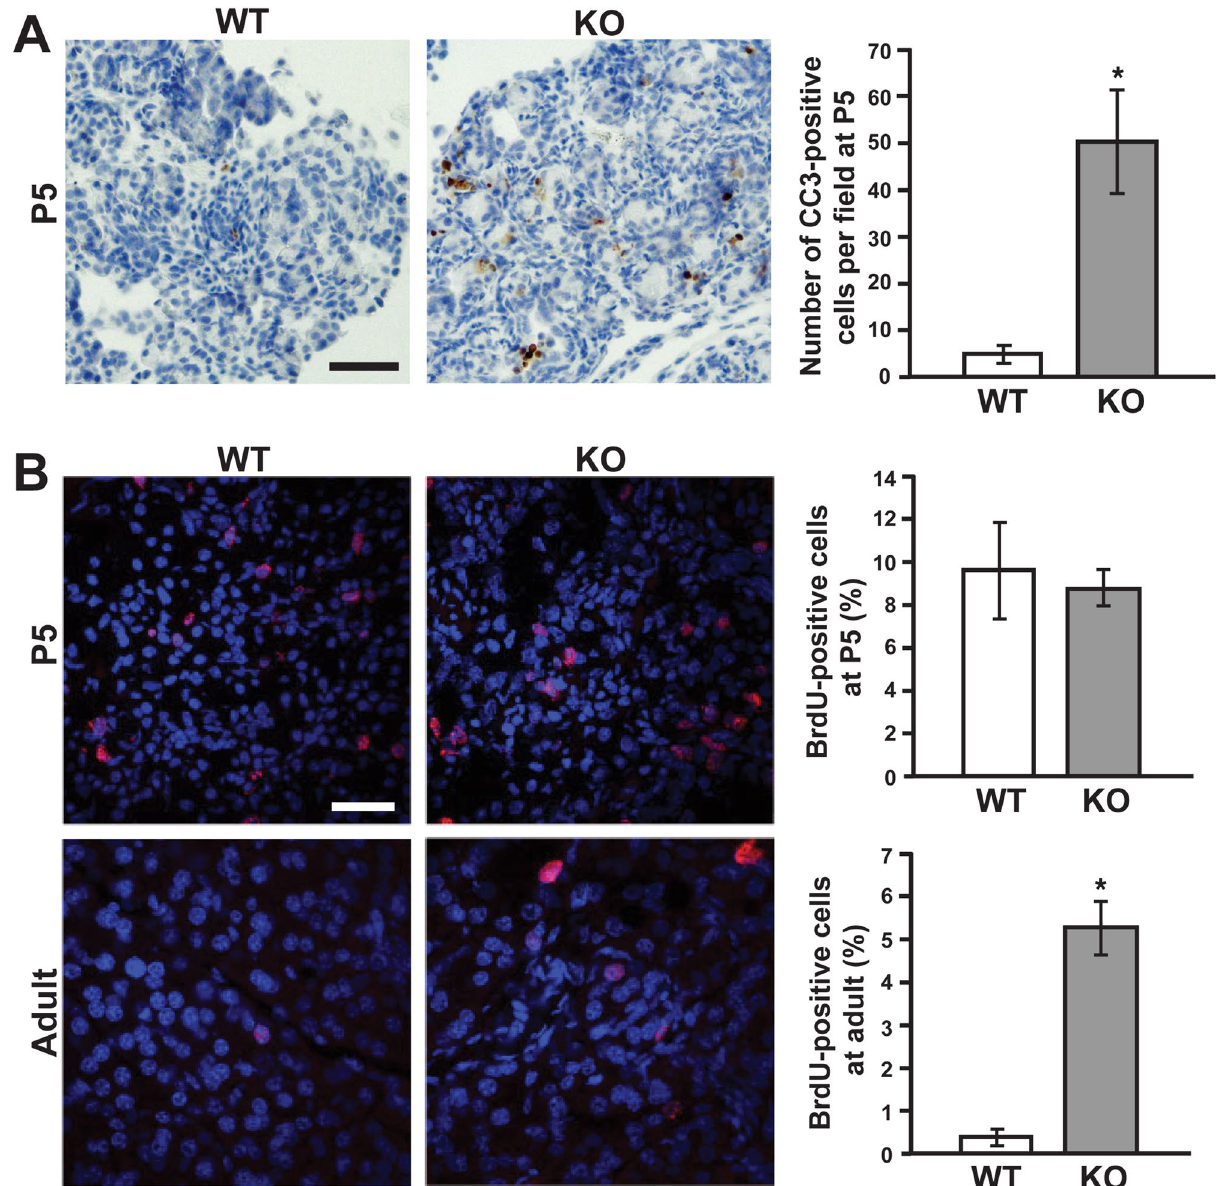
Figure 4. Apoptosis and proliferation in the pancreas. ( A ) Pancreatic sections from P5 mice were immunostained with cleaved caspase-3 (CC3) antibody and counterstained with hematoxylin to assess the level of apoptosis. Quantification represents the average of 15–20 fields (20 × objective) (n = 3 per genotype). Data represent means ± SEM. Scale bar, 50 μm. *p < 0.05. ( B ) Pancreatic sections from P5 and adult mice that were injected with BrdU were labeled with anti-BrdU antibody (red) to examine the level of proliferation. Nuclei were visualized with DAPI. The number of cells was counted in at least 10 random 63 × objective fields (n = 3 per genotype), and the percentage of BrdU-positive cells was calculated. Data represent means ± SEM. *p < 0.05. Scale bar, 20